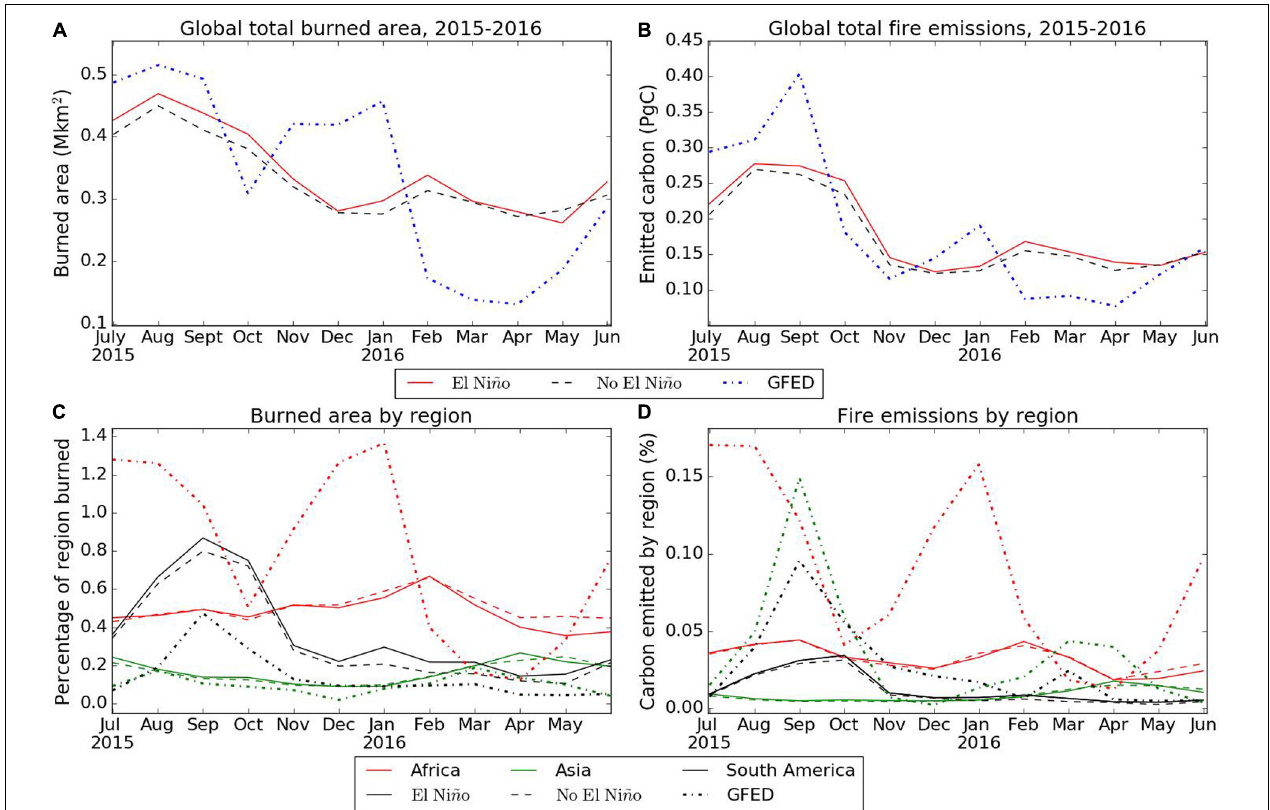
FIGURE 3 | Monthly modeled burned area and emitted carbon with observations July 2015–June 2016. Top row: Global total burned area (Mkm 2 ; A ) and emitted carbon (PgC; B ) as modeled by JULES-INFERNO with El Nino (red solid) and without El Nino (black dashed) and from GFED 4.1s observations 2015/16 (blue dot/dash). Bottom row: Modeled percentage of region burned (C) and percentage of carbon emitted from total vegetation and soil carbon by region (D) .